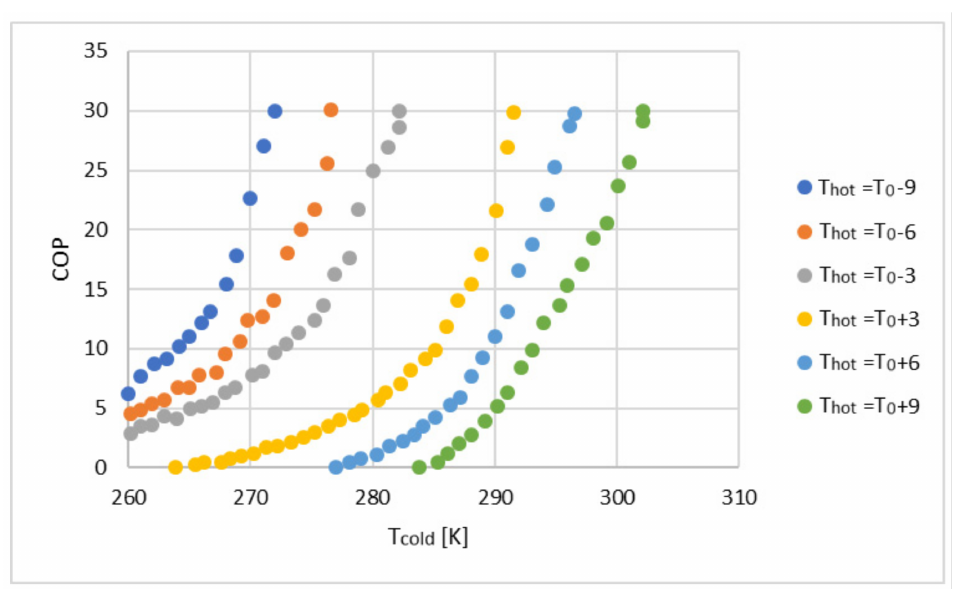
Figure 8. COP trends of an Ericsson cycle with gadolinium